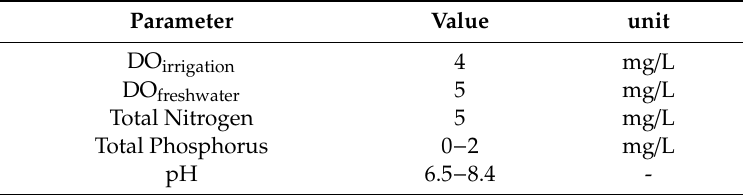
Table 3. Water quality standards approved by the Food and Agriculture Organization